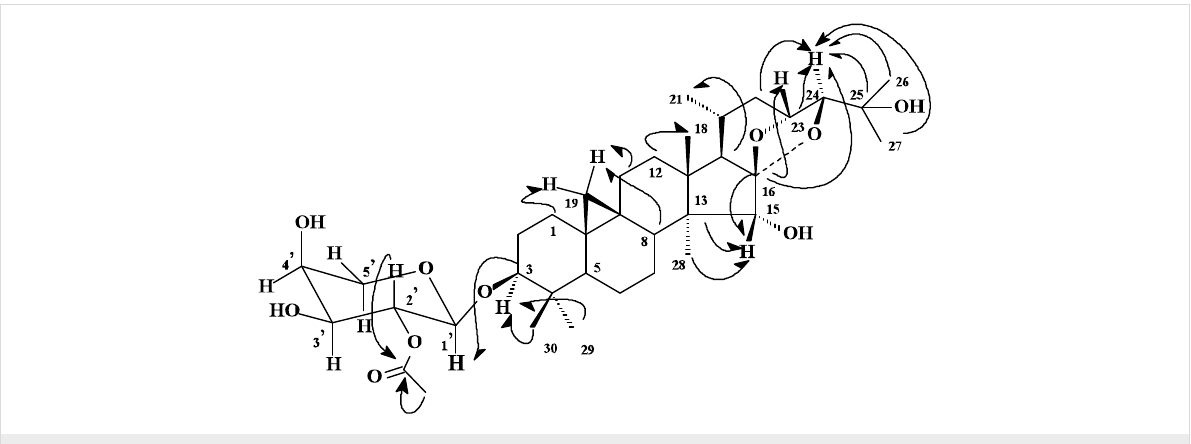
Figure 2: Key long-range 13 C- 1 H correlations of 1 observed by